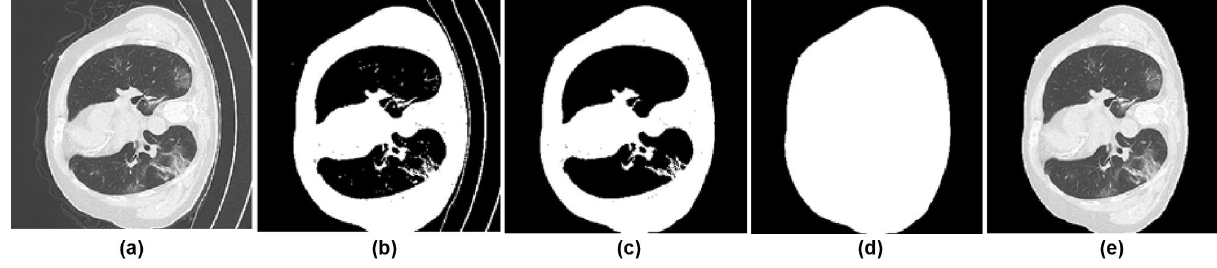
Figure 2. Different steps in Preprocessing.